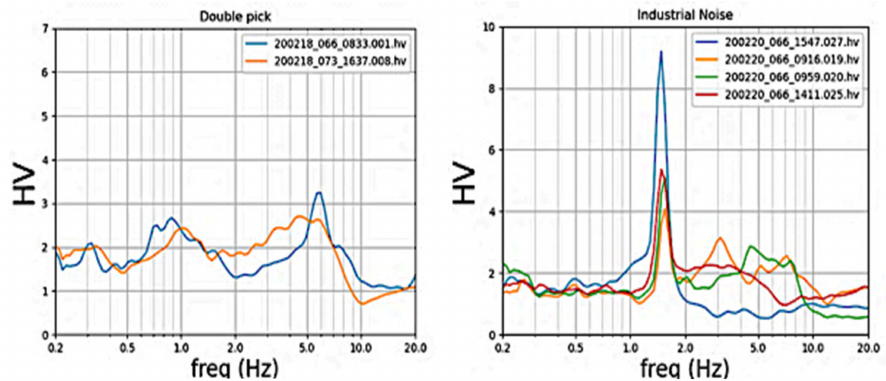
Figure 15. HVSRs of two sites exhibited double peaks ( left ); HVSRs of four sites affected by industrial noise ( right